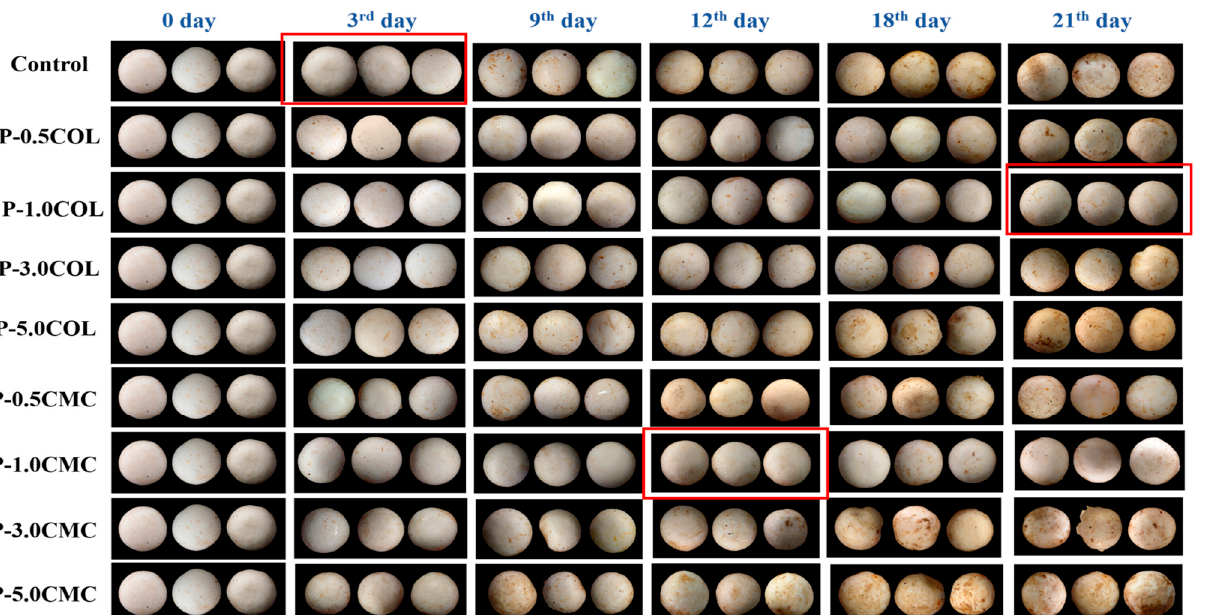
( a ) ( b ) ( c ) ( d ) Confirm and supplement Figure 4. The effects of different packaging films in the oxidative browning of A. bisporus stored at 4 °C for 21 days. ( a ) Browning index in different COL packaging films. ( b ) Browning index in different CMC packaging films. ( c ) PPO activity